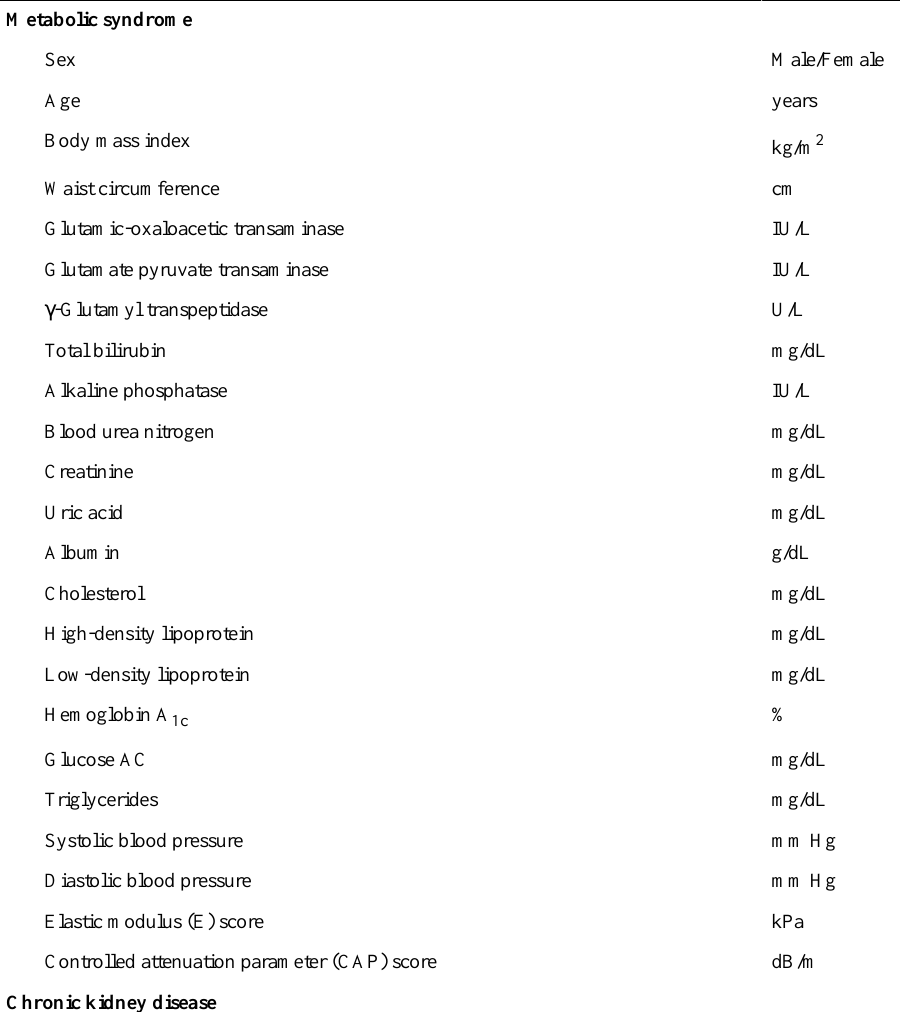
Table 1. The list of predicting variables in the electronic health care